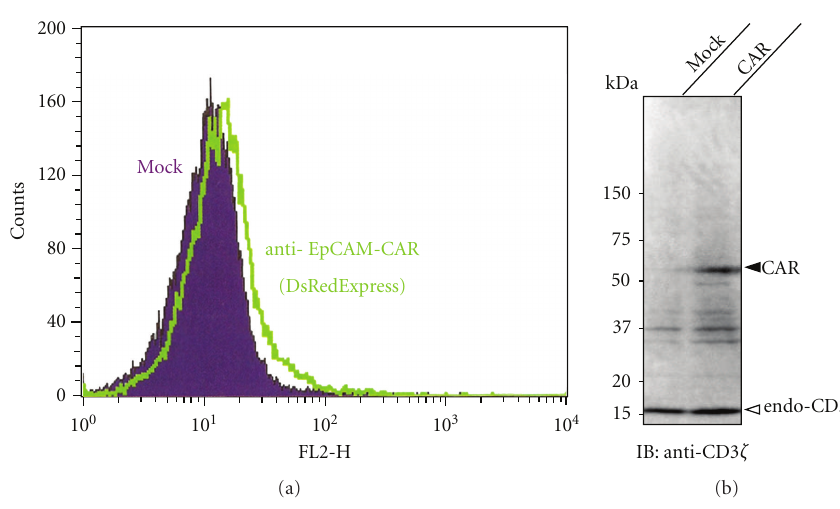
Figure 3: The results of the analysis of CAR57-28 ζ protein expression. CAR57-28 ζ -grafted Jurkat cells after hygromycin selection were analyzed by flow cytometry (a). Lysates were prepared from wild-type and CAR-expressing Jurkat cells, and immunoreactive bands were detected by a Western blotting analysis using an anti-CD3 ζ antibody